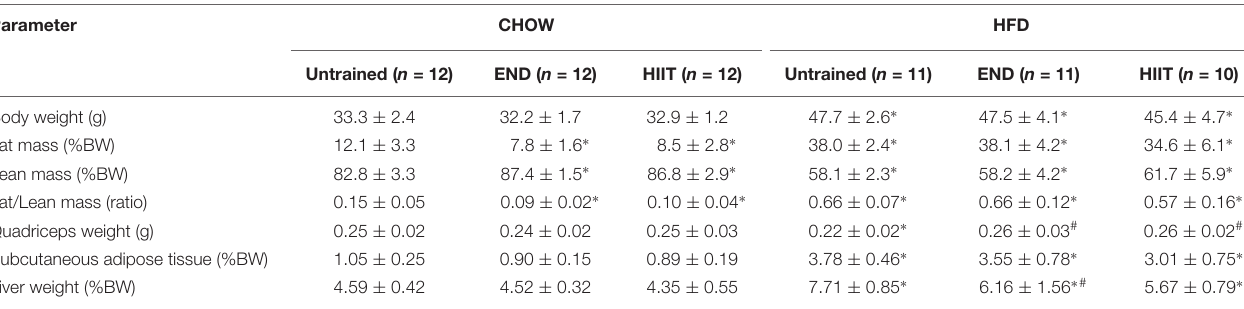
TABLE 1 | Animal characteristics at termination.